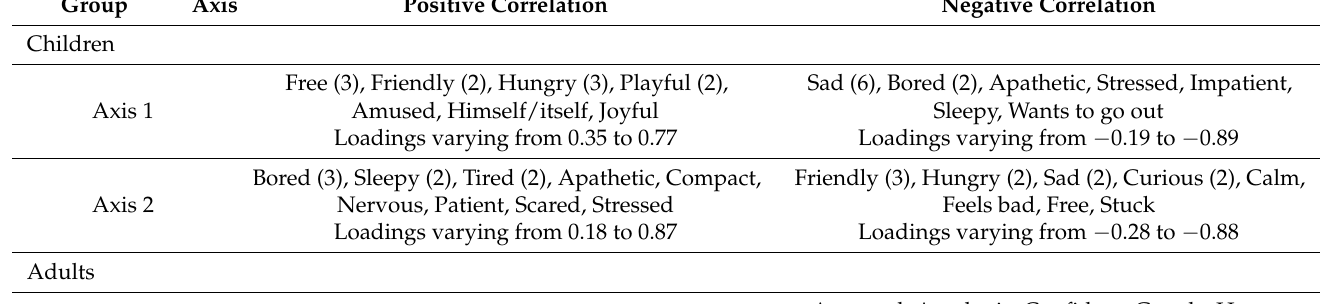
Table 4. Terms used by the observer groups showing the highest correlations with the first and second dimensions of the consensus profile (axis 1 and axis 2). The loading values near 0 indicate no correlation, whereas if near 1 indicates highly and positively correlated values. The closer the values are to − 1, the more inverse the correlation is. The values in brackets indicate the number of observers using the specific terms, unless used by 1 observer.